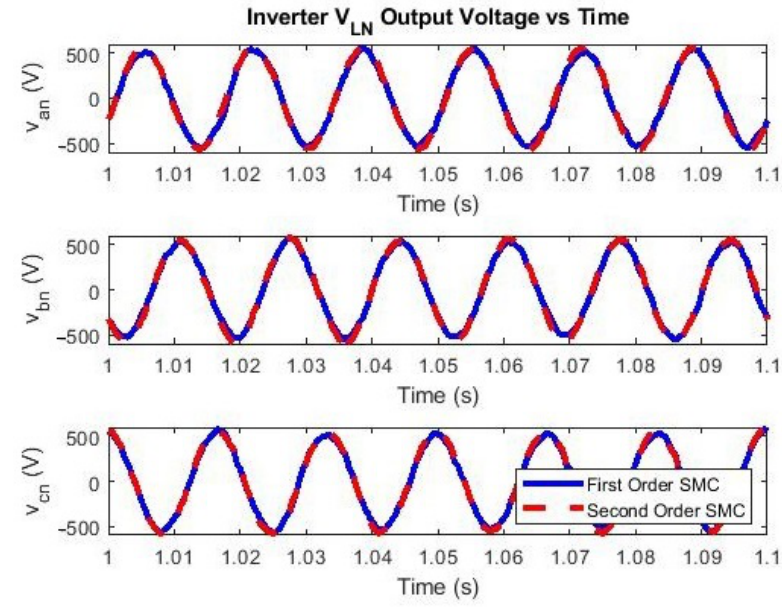
Figure 26. SVPWM inverter V LN output voltage under changing irradiation.